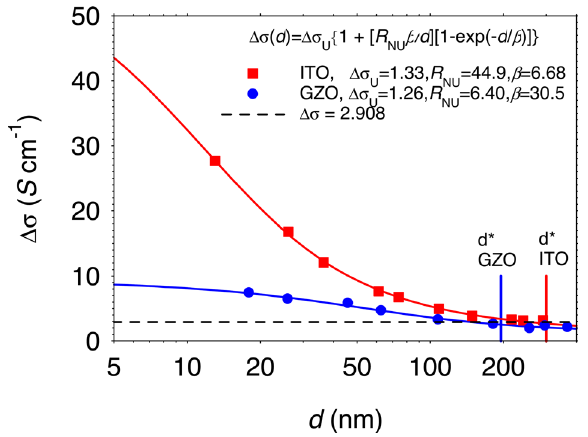
Fig. 8 Thickness dependence of magnetoconductivity in different materials. Comparison of interface quality for different materials, Sn-doped In 2 O 3 (ITO) and Ga-doped ZnO (GZO), grown by the same method (pulsed laser deposition) on the same substrate material (fused silica) using the same apparatus. Squares, ITO. Circles, GZO. Solid lines, fi ts to Δ σ ( d ) = Δ σ + [ R β / d ][1 – exp( − d / β )]}. The fi gure of merit, d * = R U {1 NU nm for ITO and 195 nm for